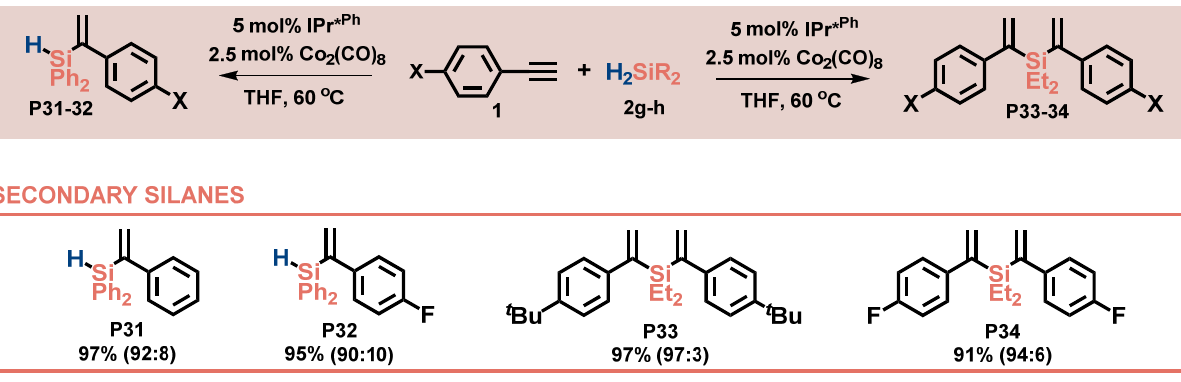
Figure 5. Substrate scope—secondary silanes. Reaction conditions: argon, THF, 60 °C, 12 h, [ 1a ]:[ 2g- h ] = 2:1, [IPr* Ph ] = 5 mol%, [Co] = 2.5 mol%; isolated yields are given under the product structure. Selectivity α : β -(E) is given in the parentheses.